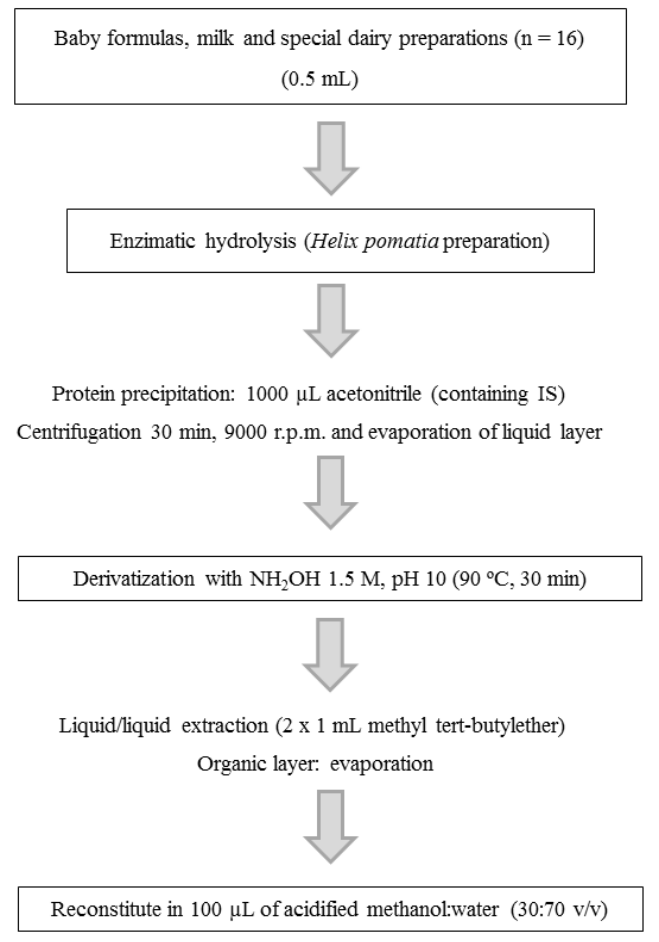
Figure 2. Overview of the sample preparation used for HPLC-MS/MS analysis of milk